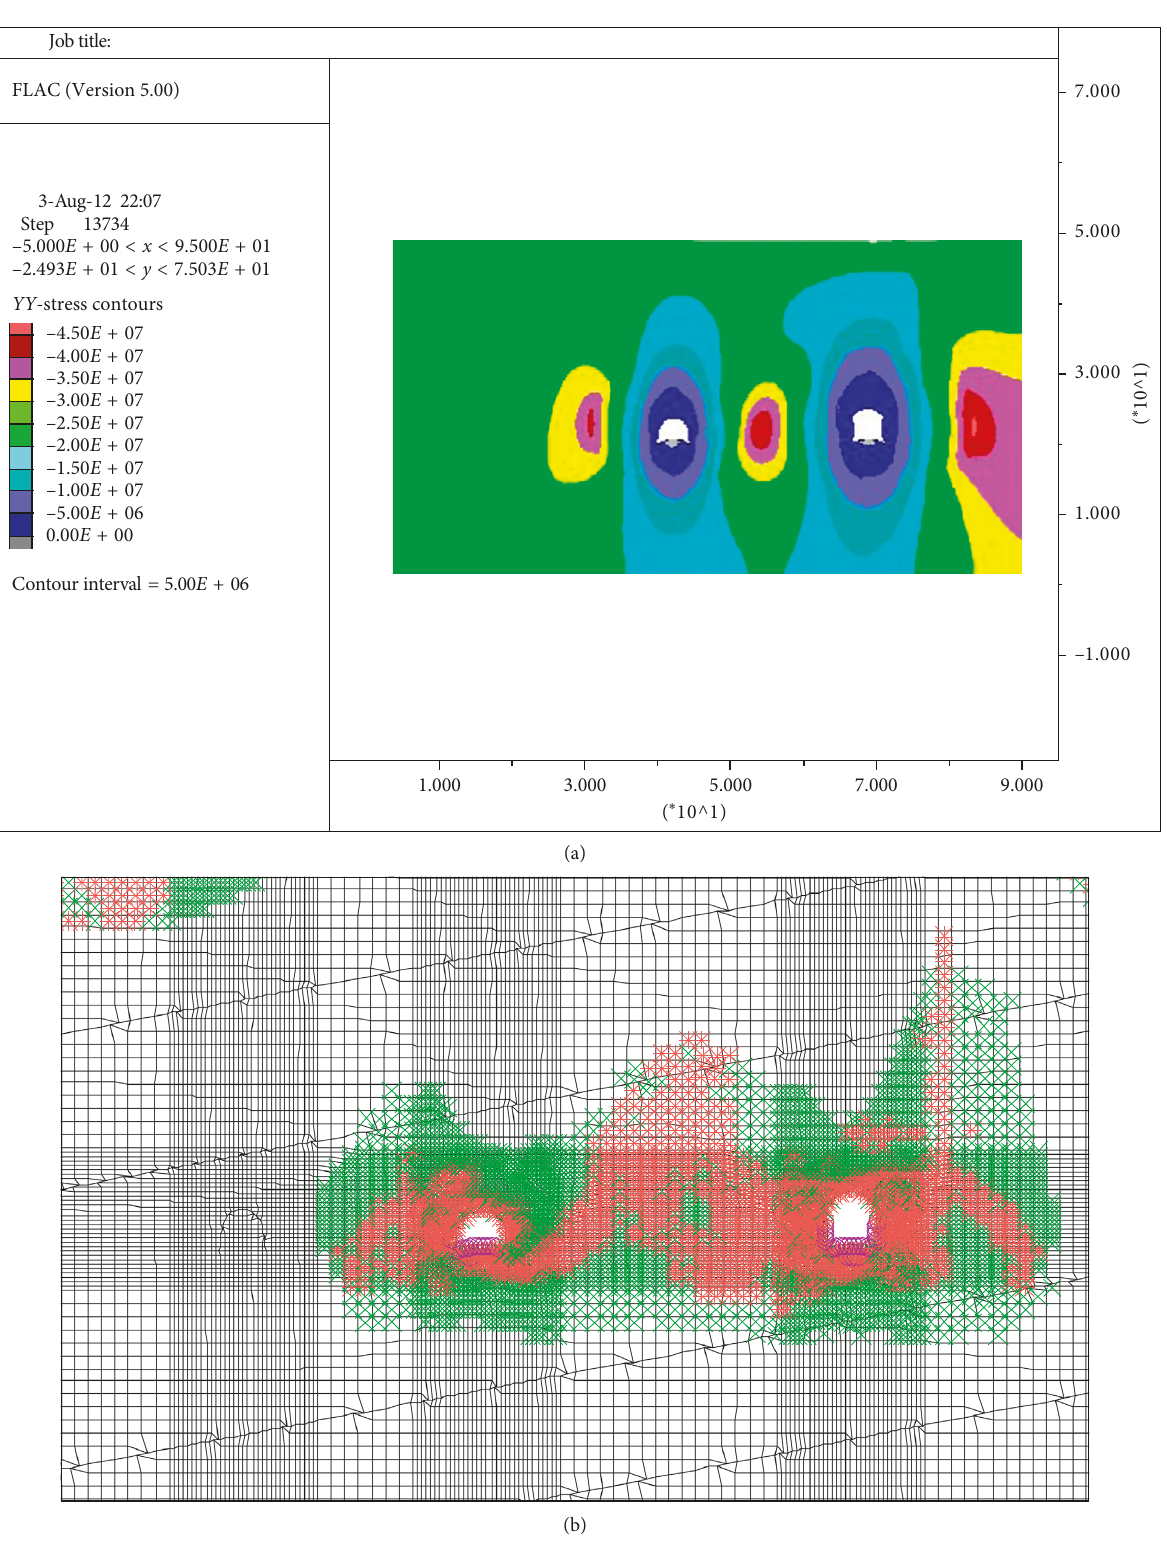
Figure 6: Calculation results when the excavation of the water pump house and main haulageway at the same time is done: (a) vertical stress of surrounding rock; (b) plastic zone of surrounding